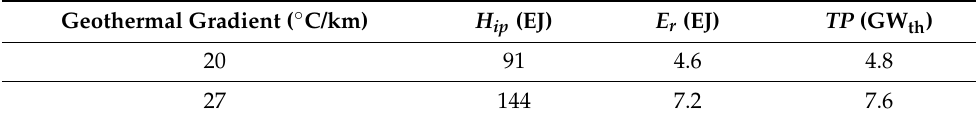
Table 5. Geothermal potential assessment: 1 EJ = 1 × 10 18 J.